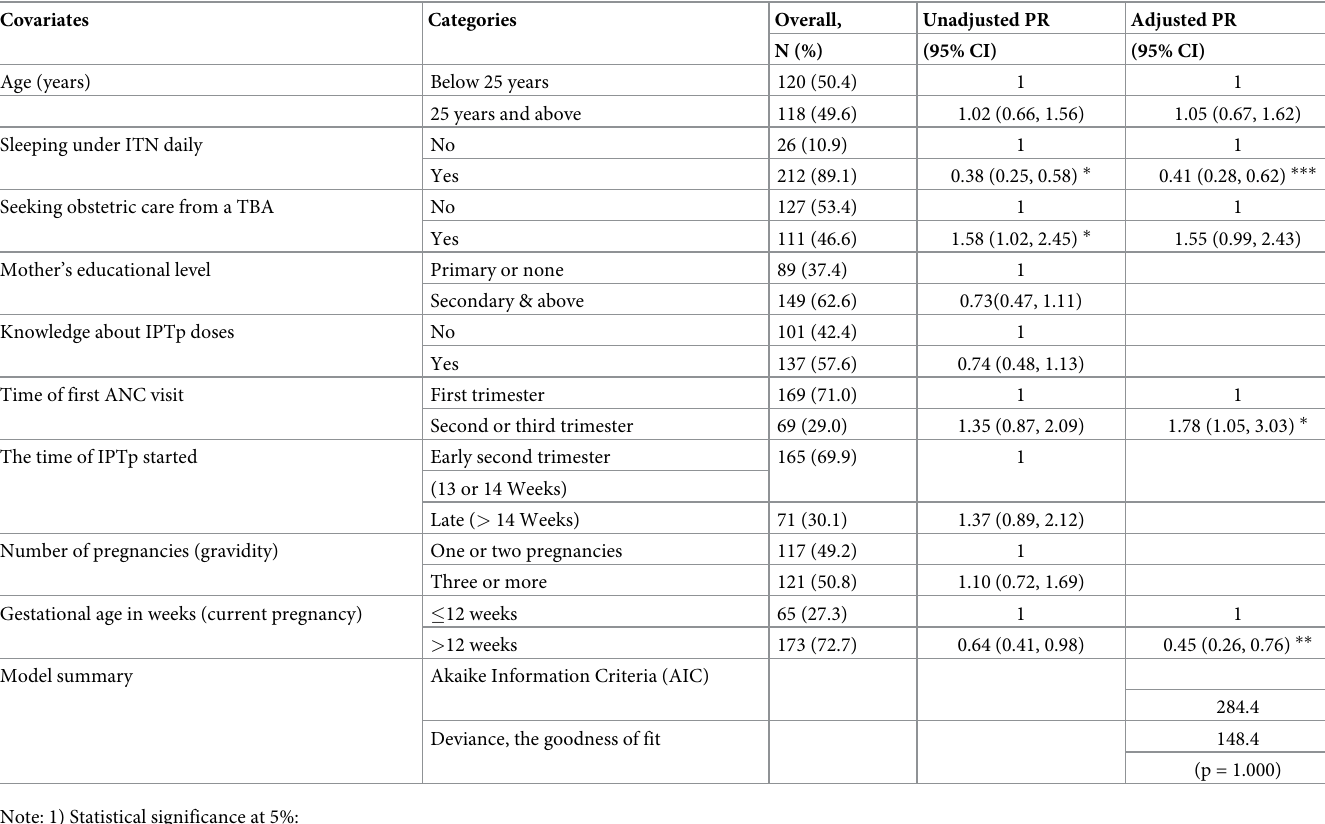
Table 2. Modified Poisson regression analysis of factors associated with malaria in